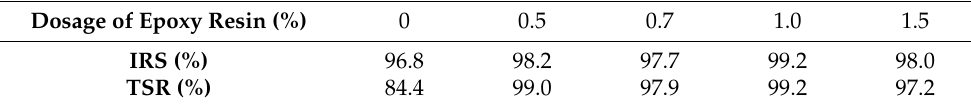
Table 6. Effects of epoxy resin on the water damage resistance of BRA-rejuvenated RAP. Dosage of Epoxy Resin